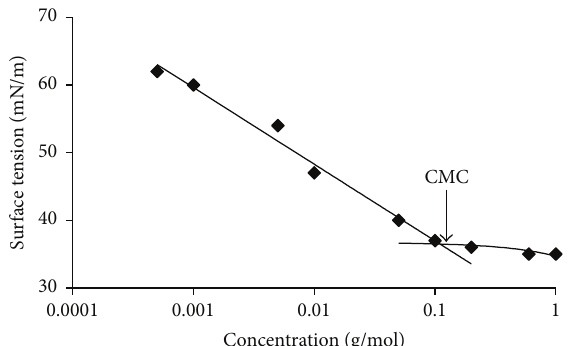
Figure 2: Schematic representation of determining CMC of sam- ples.